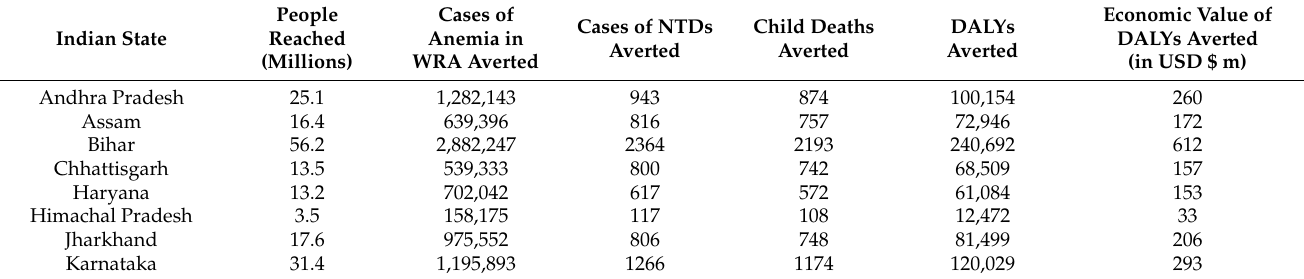
Table A1. Estimated annual health impact and economic value of fortification at scale: 17 Indian states. Indian